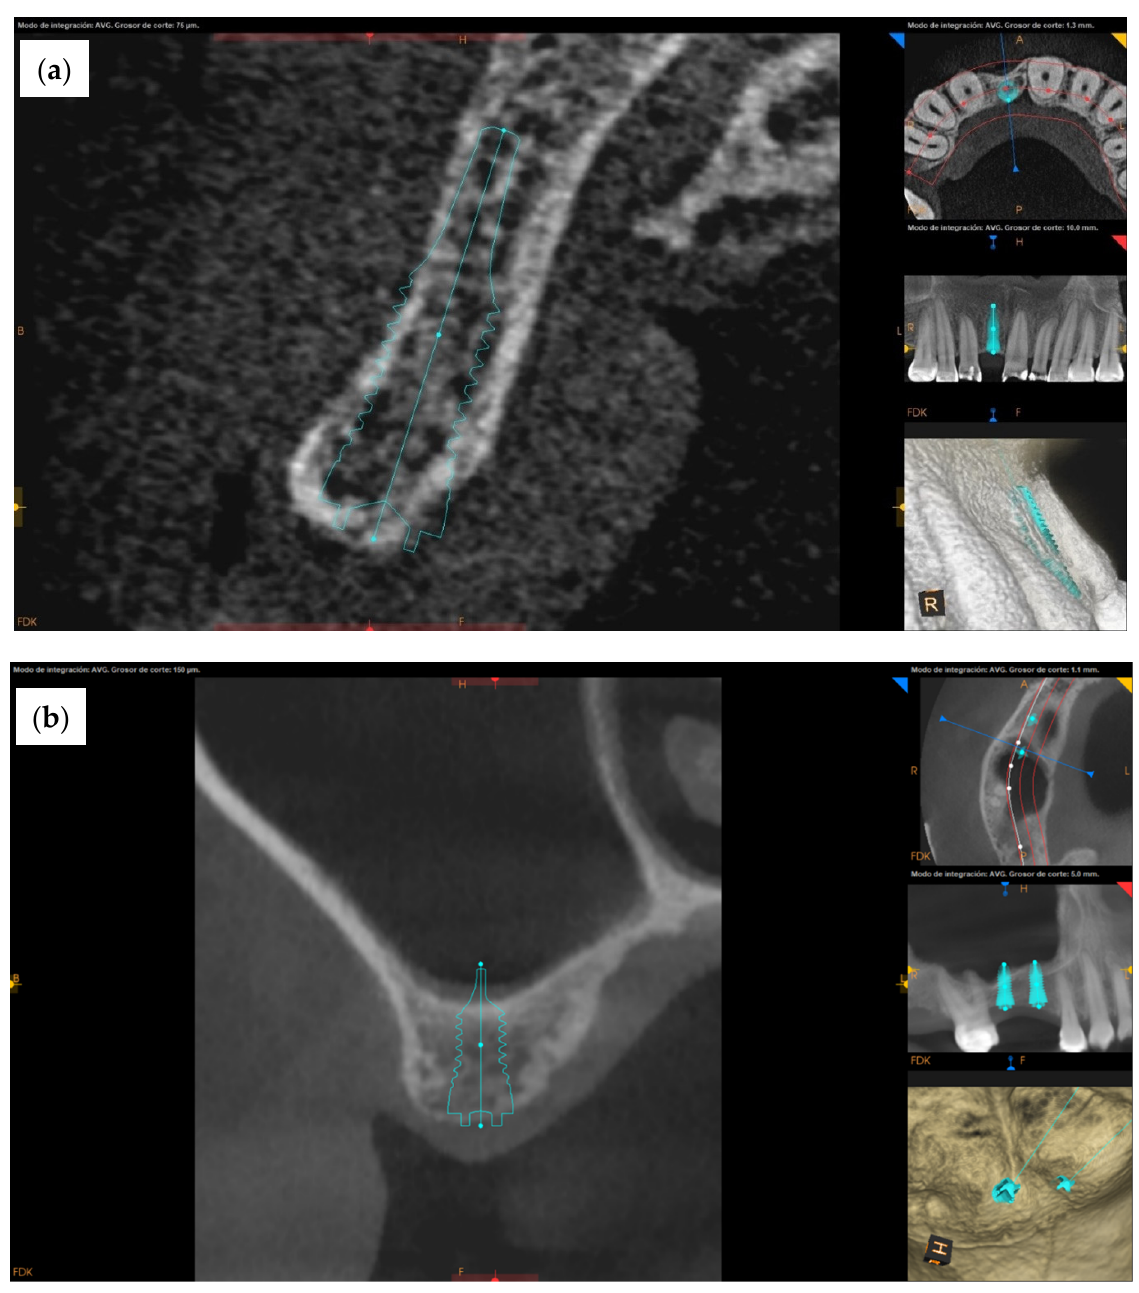
Figure 2. Pre-operative diagnostics and implant treatment plan. CBCT images prior to surgery from two selected clinical cases. ( a ) A 38-year-old female with a missing maxillary central incisor (FDI position 11) and a horizontally compromised ridge, planned for a single implant-supported restoration with simultaneous guided bone regeneration. ( b ) A 47-year-old female with two missing teeth at FDI positions 15 and 16, planned for placements of two implant with simultaneous sinus floor elevation (crestal approach).